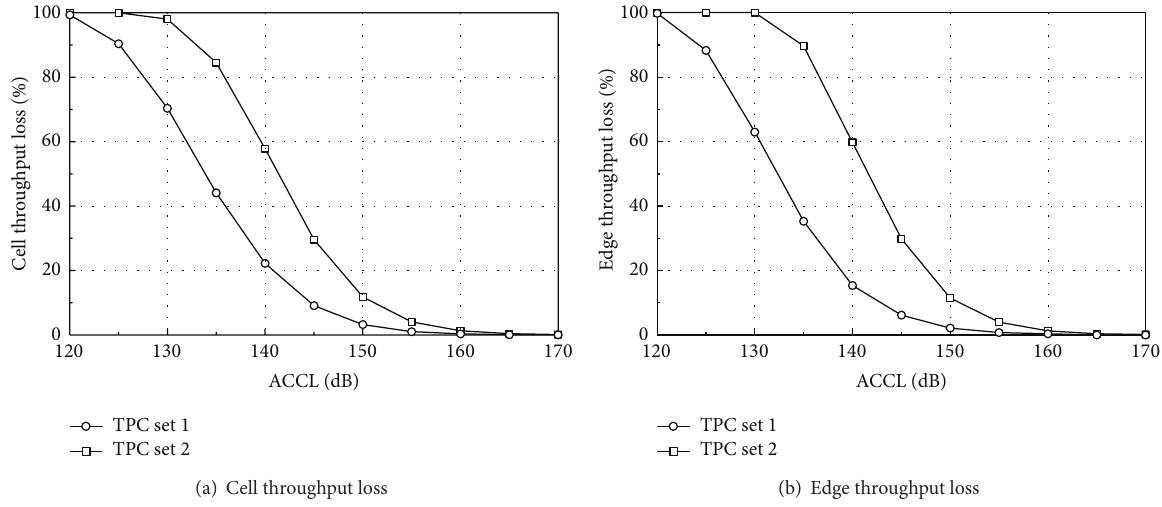
Figure 11: Throughput loss of unsynchronized uplink